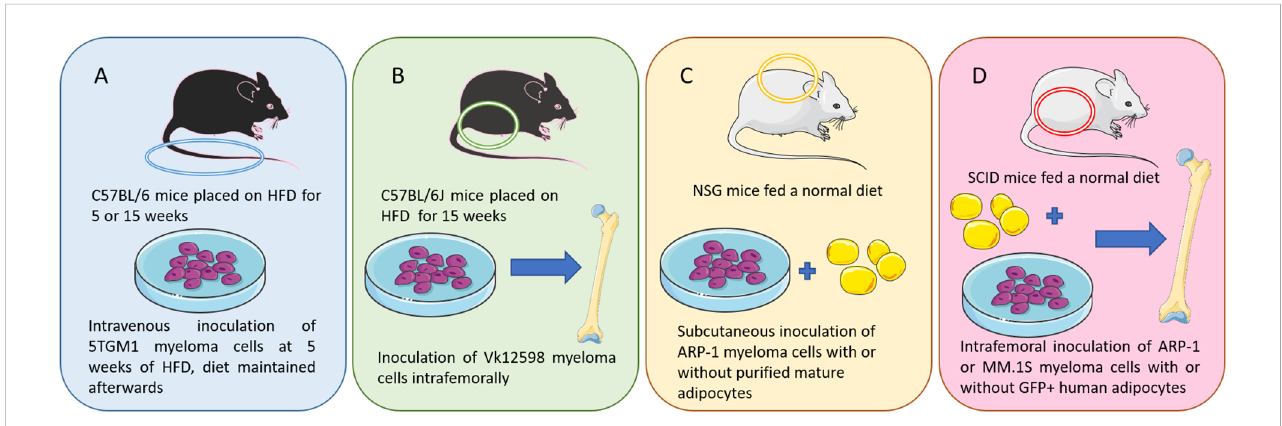
FIGURE 1 Murine models of multiple myeloma: (A) I.V. injection of 5TGM1 MM cells in C57BL/6 mice on a high fat diet (a diet-induced obesity model) (58). (B) Intrafemoral injection of Vk12598 MM cells in C57BL/6J mice on a high fat diet (a diet-induced obesity model) (59). (C) Subcutaneous inoculation of ARP-1 MM cells and adipocytes in NSG mice (59). (D) SCID mouse femurs injected with MM cells (ARP-1 or MM.1S) or co-injected with MM cells and GFP-labeled mature human adipocytes (60). Figure includes modi fi ed templates from Servier Medical